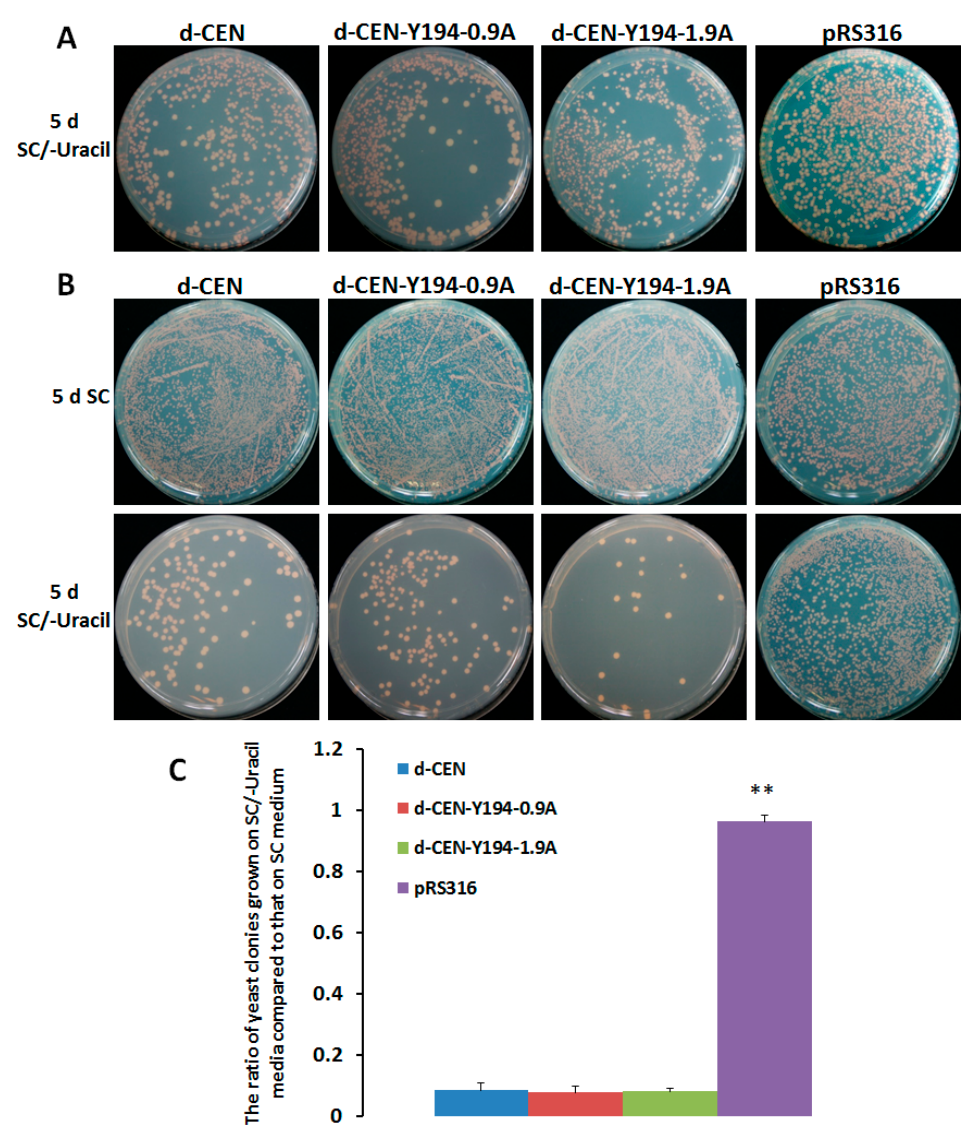
Figure 5. Identification of the centromere (CEN) element in Y194. ( A ) W303-1B yeast cells were transformed with d-CEN (negative control), d-CEN-Y194-0.9A, d-CEN-Y194-1.9A and pRS316 (positive control), individually. Photographs were taken at 5 d after transformation. ( B ) Yeast cells containing the indicated plasmids from ( A ) were cultured for 90-h generations in the SC liquid plate, and then were spread in the SC and SC/–uracil solid plate. Photographs were taken at 5 d after plating. ( C ) The ratio of yeast colonies grown on SC/–uracil media compared to that on the SC plate from ( B ). Three independent transformations with the indicated plasmids ( A ) were performed, and the values represent the average numbers of yeast colonies emerging on the SC/–uracil media compared to SC plate after 5 d of transformation. Values represent the mean ± standard deviation (SD). The data were analyzed using Student’s t -test and double asterisks denote a highly significant difference compared to d-CEN (** p < 0.01).